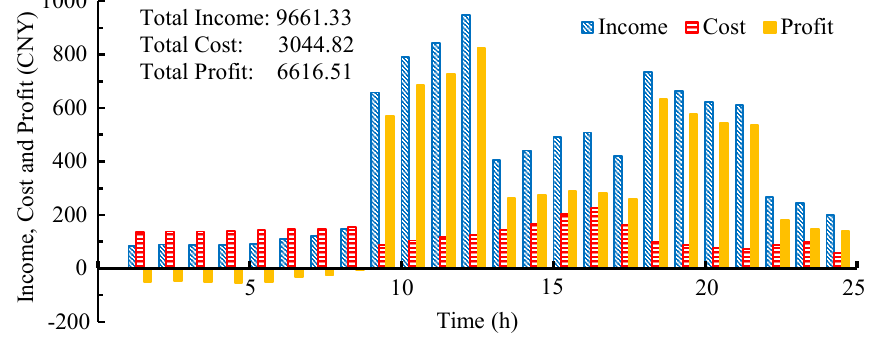
Figure 12. Income, cost and profits of the microgrid in 24